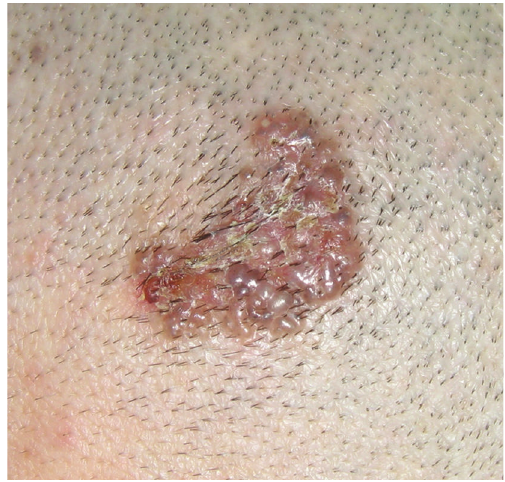
Figure 1: Macroscopic appearance of the lesion on the scalp.